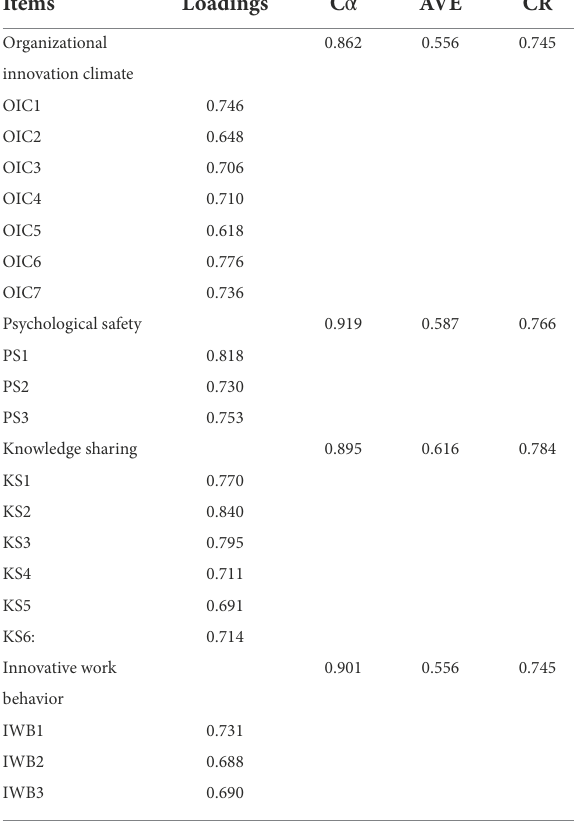
TABLE 2 Reliability and validity tests.